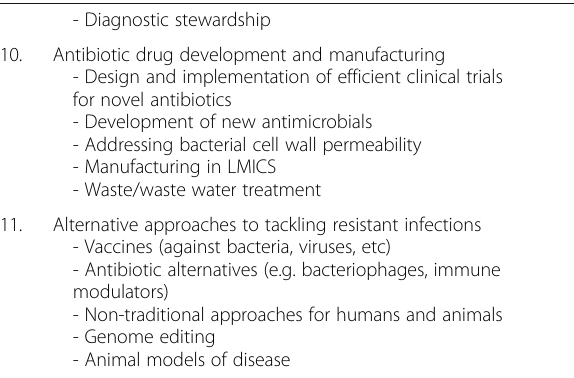
Table 1 Double AMR track proposed for the World One Health